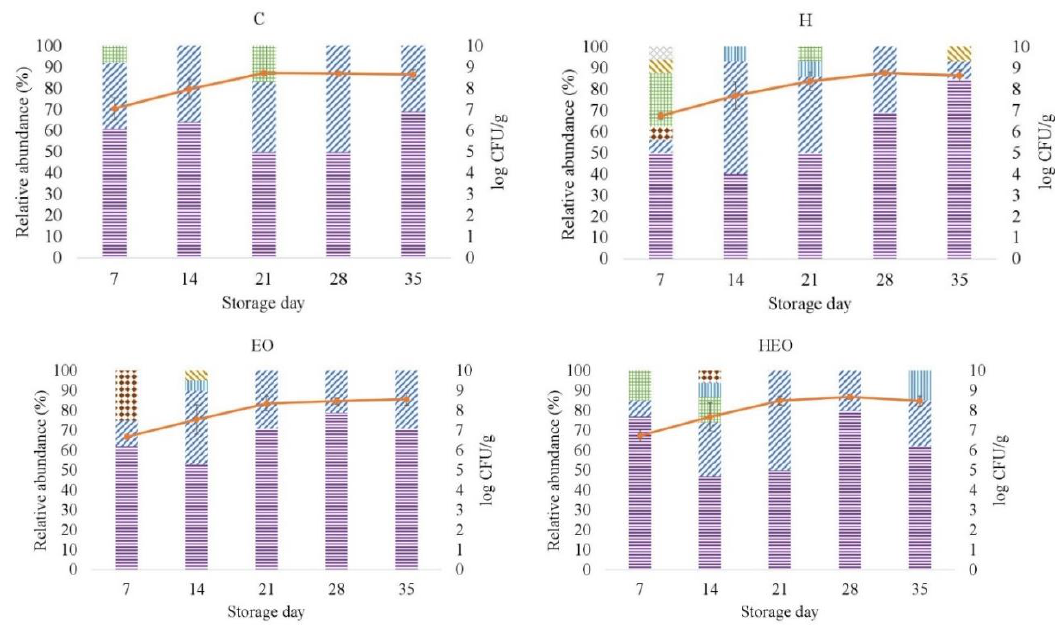
Figure 2. Relative abundance (%) and growth curve (mean and standard deviation, vertical bars; n = 3) of the isolates identified as lactic acid bacteria in fresh lamb sausages packaged under modified atmosphere (80% N 2 , 20 %CO 2 ) during refrigerated storage (4 °C). CFU: Colony forming unit. C: Control sausages; H: hops; EO essential oil ( Zataria multiflora Boiss); HEO: hops and essential oil.